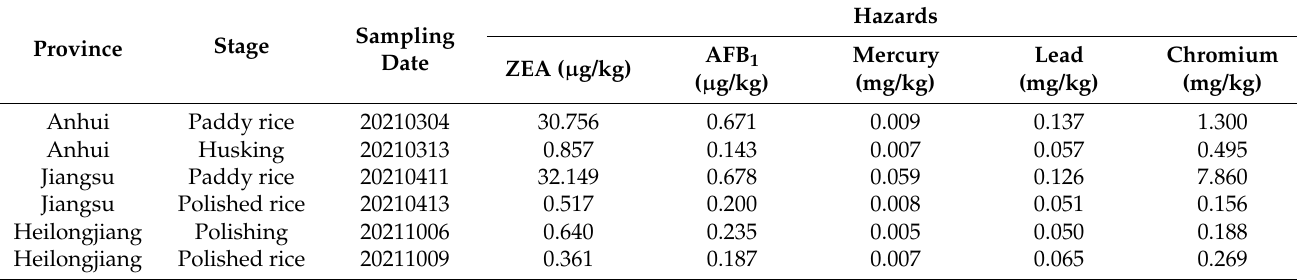
Table 2. Sample of rice hazards